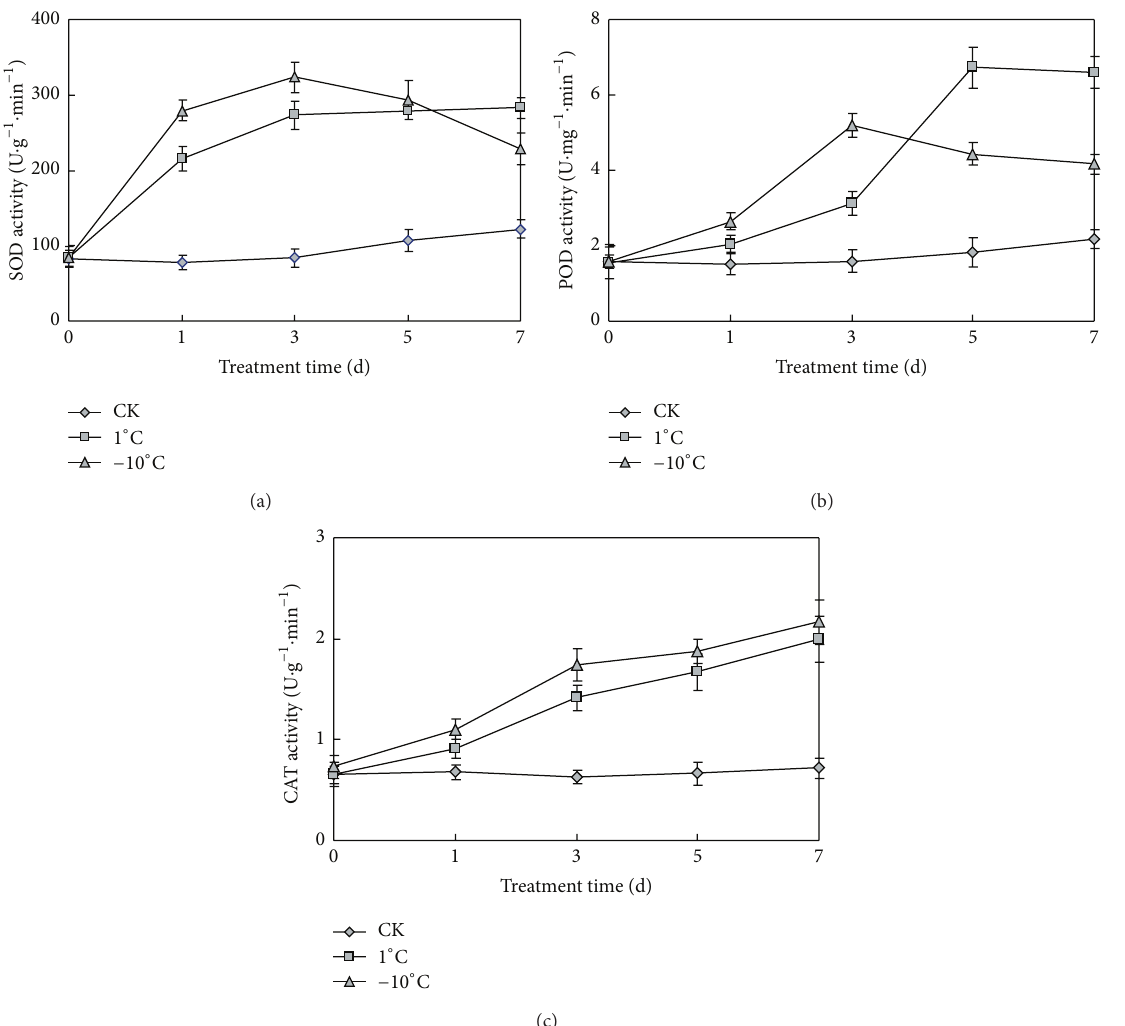
Figure 6: Activities of SOD (a), POD (b), and CAT (c) of seedling leaves under normal and low temperatures. CK represents normal growth condition. Each value is the average ± standard error ( ± SE) result of three independent